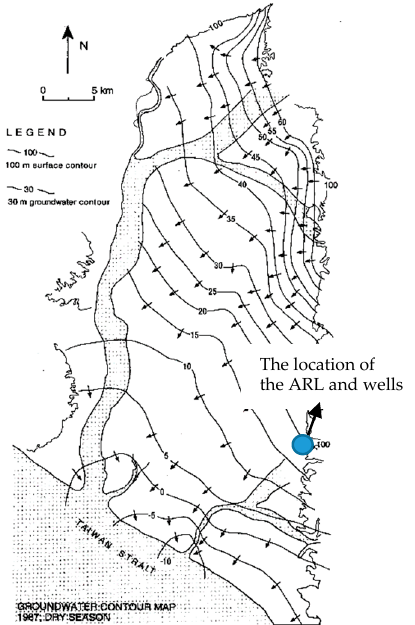
Figure 4. Groundwater piezometric map of the Pingtung Plain’s dry season (November to May) [26].